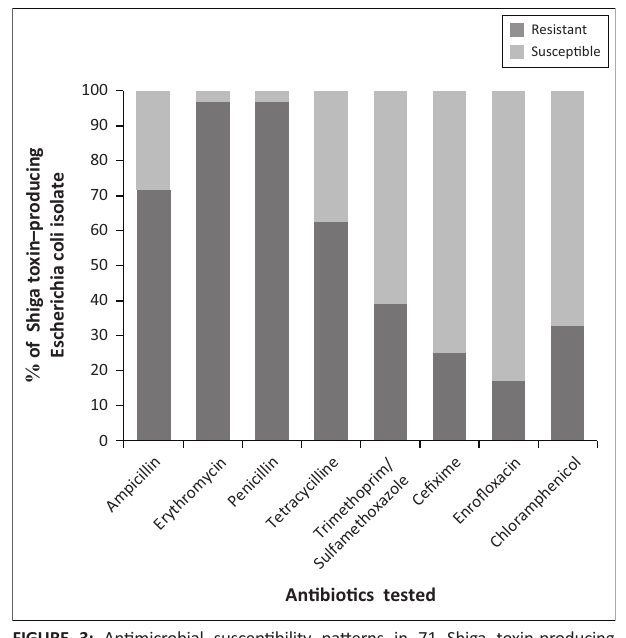
FIGURE 3: Antimicrobial susceptibility patterns in 71 Shiga toxin-producing Escherichia coli strains.